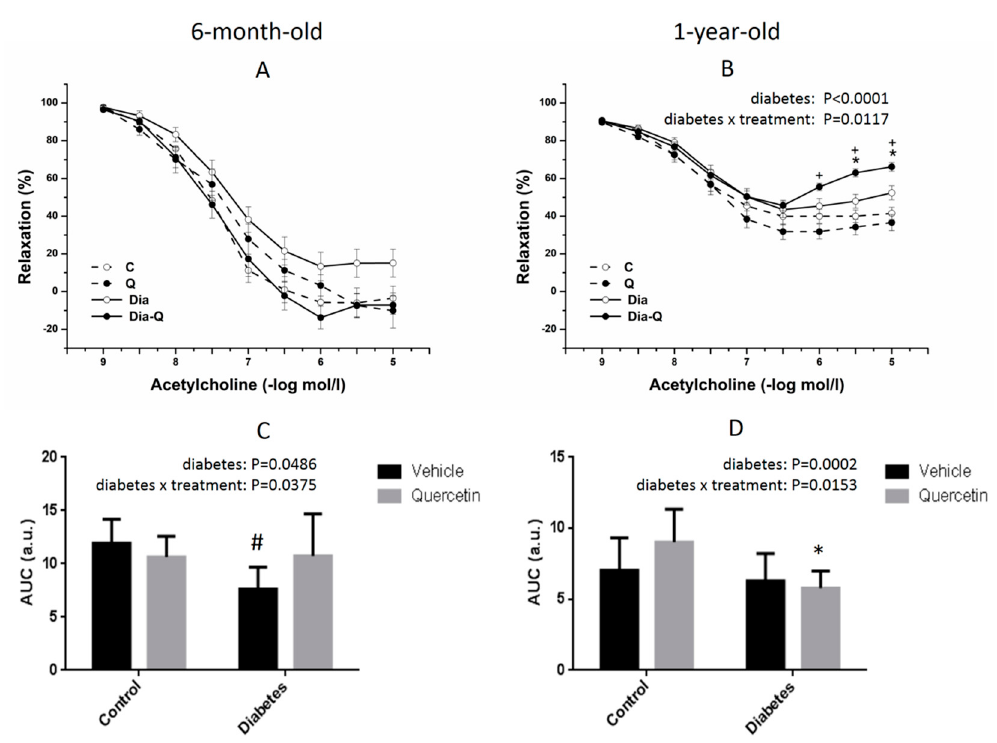
Figure 2. Maximal and overall relaxation of thoracic aorta: diabetes dependence. The endothelium- dependent vasorelaxant responses of thoracic aorta induced by acetylcholine in younger ( A ) and older ( B ) rats; and e ff ect of treatment with quercetin on overall acetylcholine-induced relaxation of thoracic aorta in younger ( C ) and older ( D ) rats. AUC—area under the curve; a.u.—arbitrary units. Results are expressed as mean ± SEM. Significant di ff erences were evaluated by two-way ANOVA for main factors diabetes and quercetin treatment (shown for maximal ( A , B ) and overall ( C , D ) relaxation). Tukey post hoc test was used to describe the di ff erences in mean values of the experimental groups. # p < 0.05 vs. C; * p < 0.05 vs. Dia; + p < 0.05 vs. Q.